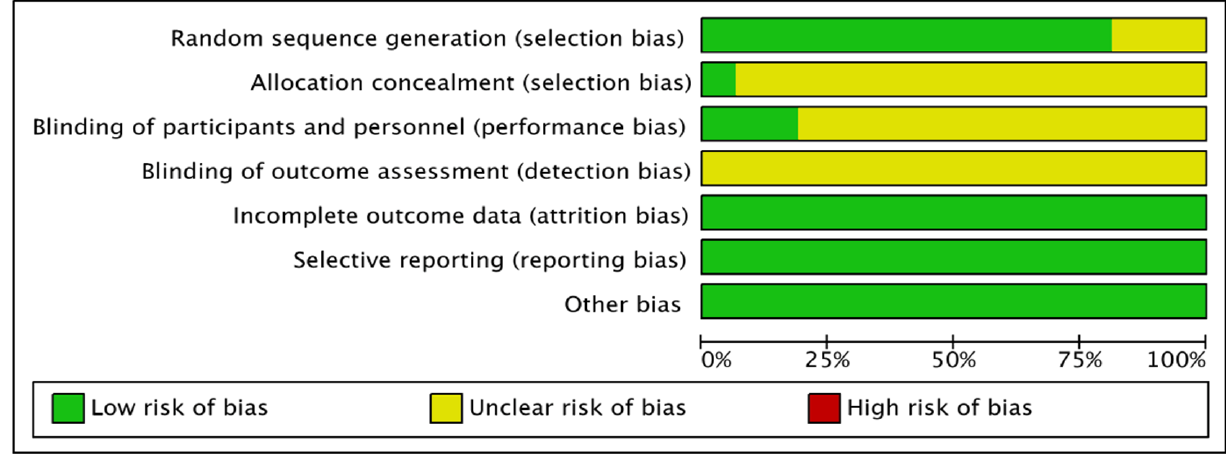
Figure 2. Summary of the risk of bias in the included literature.